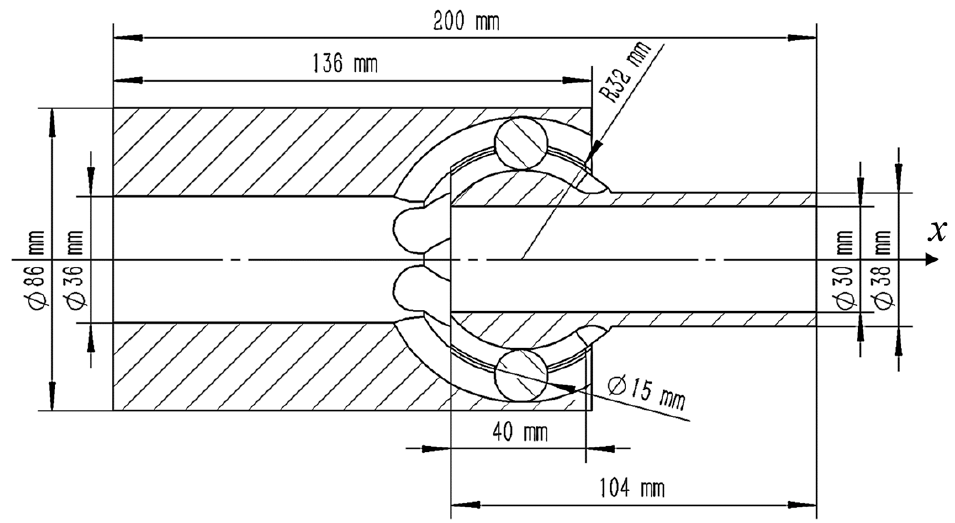
Figure 3. Structural parameters of ball cage flexible joint.